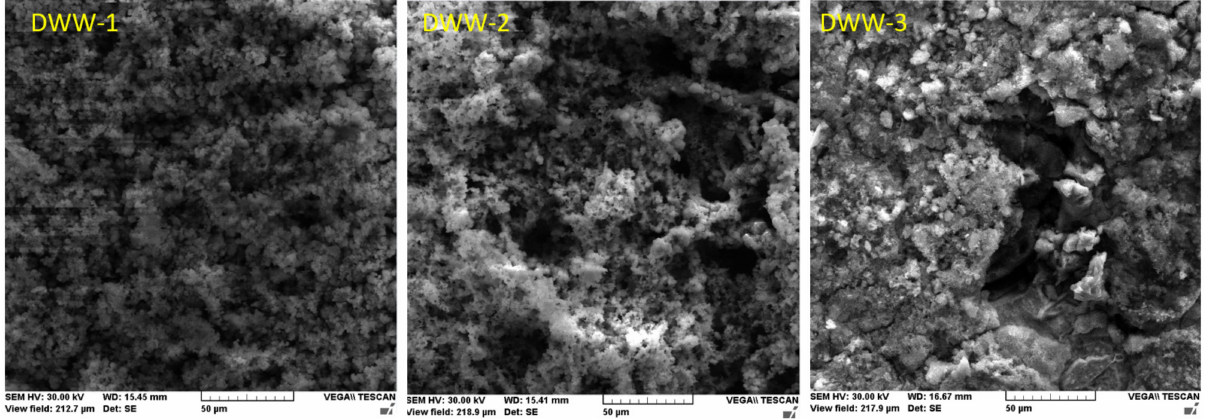
Figure 24. SEM micrographs of crusts at 1000 × magnification. The sample crust composition immersed for 90 days in DWW-1 simulated domestic water is illustrated in Figure